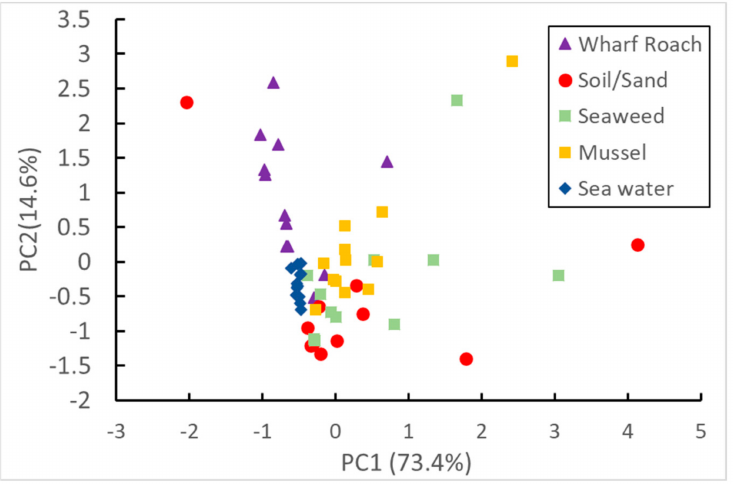
Figure 7. PCA score plot in which the first two PCs account for 88% of the